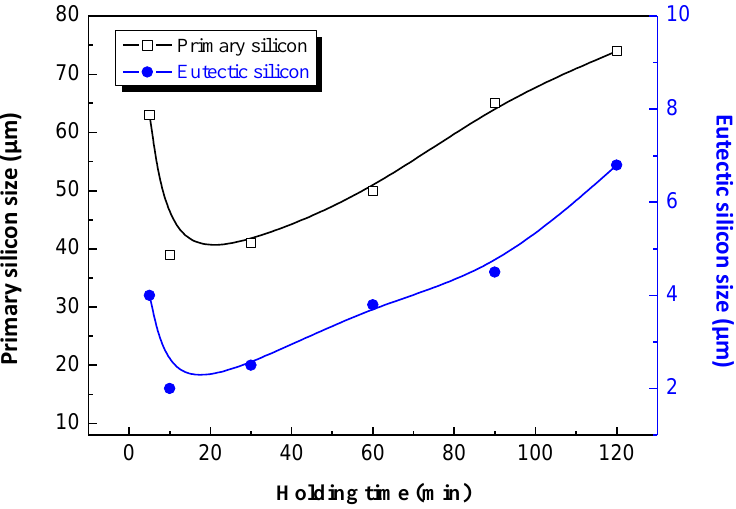
Figure 8. The relation curve between holding time and the size of primary Si and eutectic Si in hypereutectic Al–20%Si alloy with 0.6 wt% Al–5Ti–C master